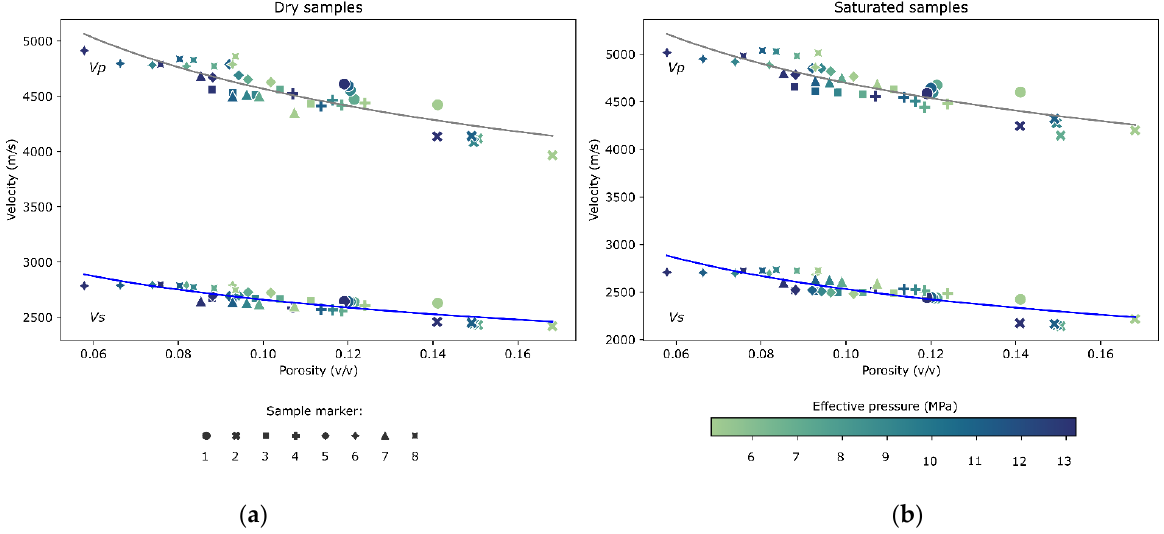
Figure 6. Velocity versus porosity crossplot of dry ( a ) and saturated ( b ) samples under different effective pressures.